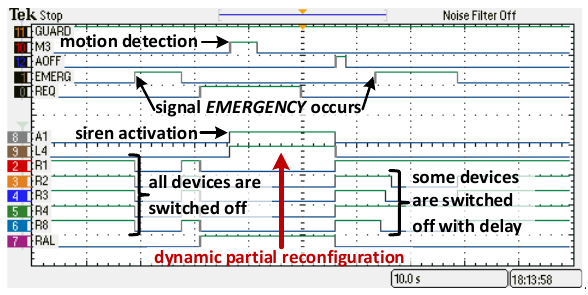
Figure 19. SHS—dynamic partial reconfiguration of the SHS.